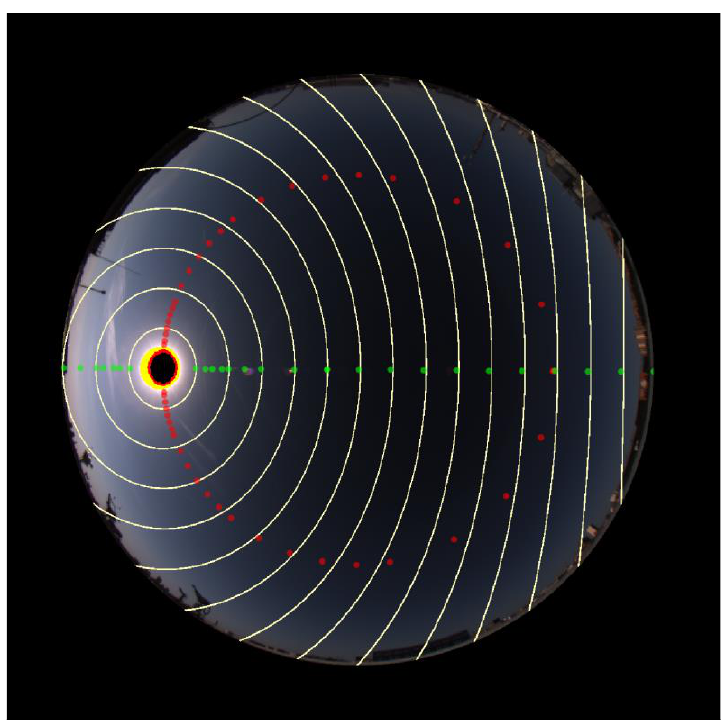
Figure 7. Examples of the representation of the almucantar (red dots) and principal (green dots) planes of the sun in an image on 27 June 2021 at 07:30. Isolines of different scattering angles are also shown with a 10° step.